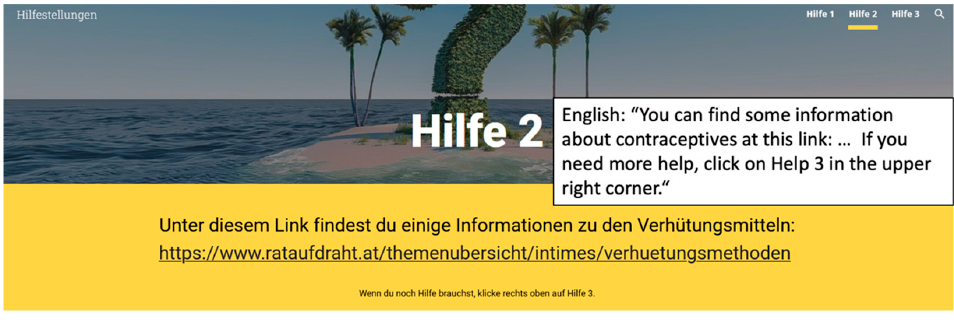
Figure 3. Example of a sequential learning aid .